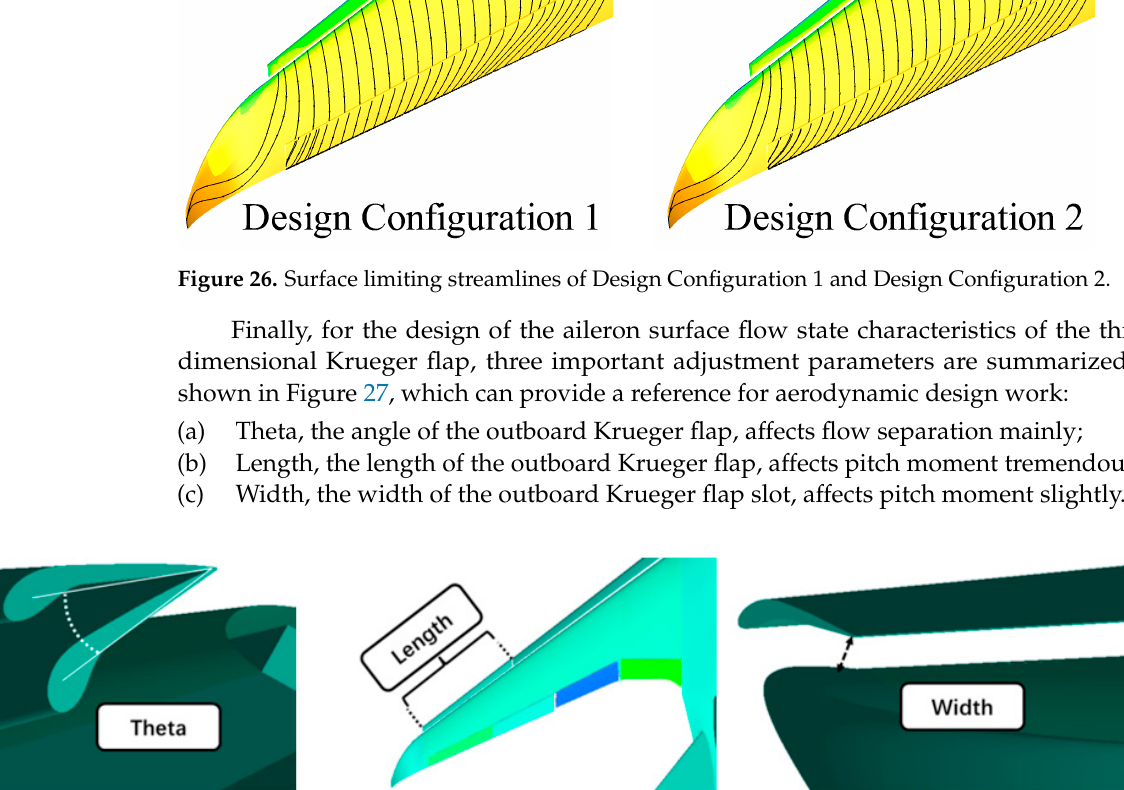
Figure 27. Adjustment parameters of the Krueger flap for the improvement of aileron surface flow state.